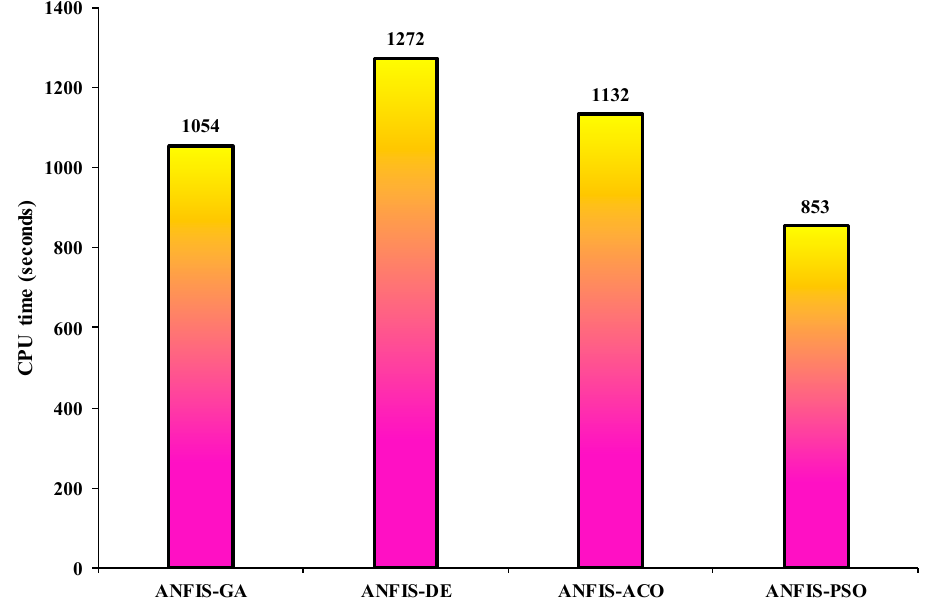
Figure 7. Comparison between computational time (CPU time) obtained from hybrid ANFIS models.